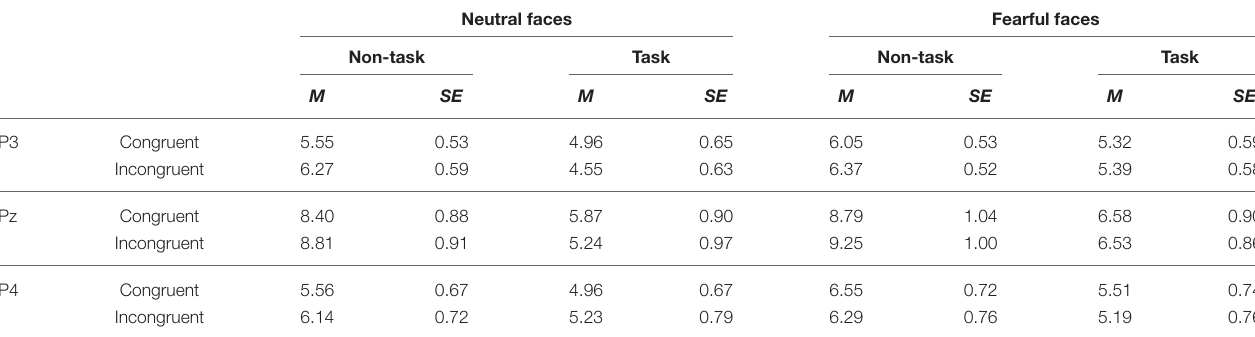
TABLE 5 | Mean of P3 amplitude ( µ V) and its SE for all the experimental conditions. Neutral faces Fearful faces Non-task Task Non-task